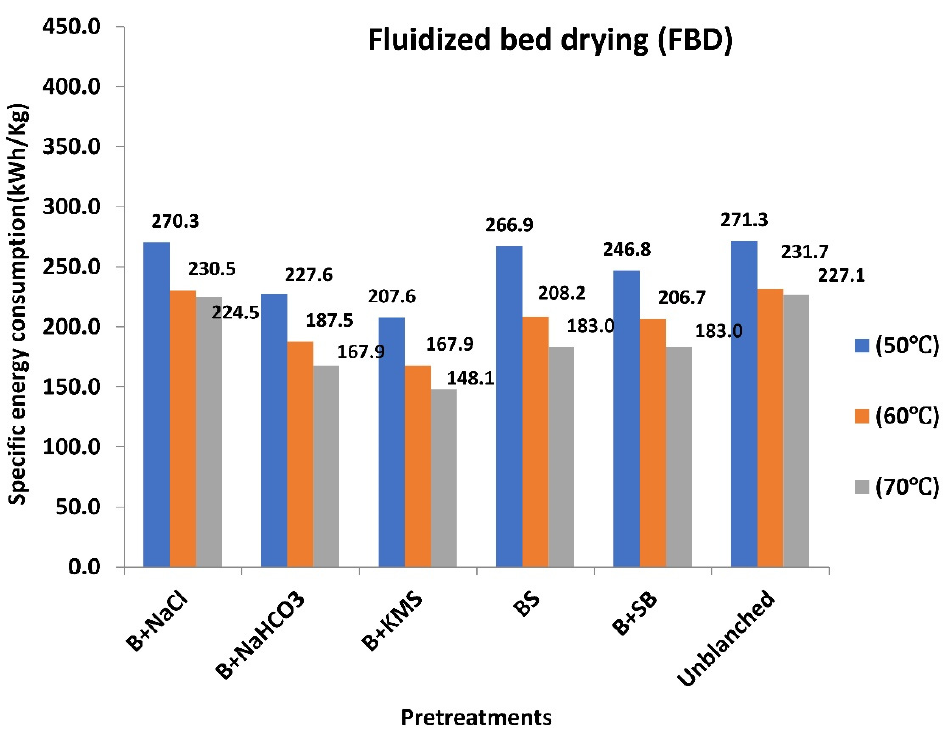
Figure 8. Specific energy consumption under various pretreatments and drying temperatures in fluidized bed dryer.